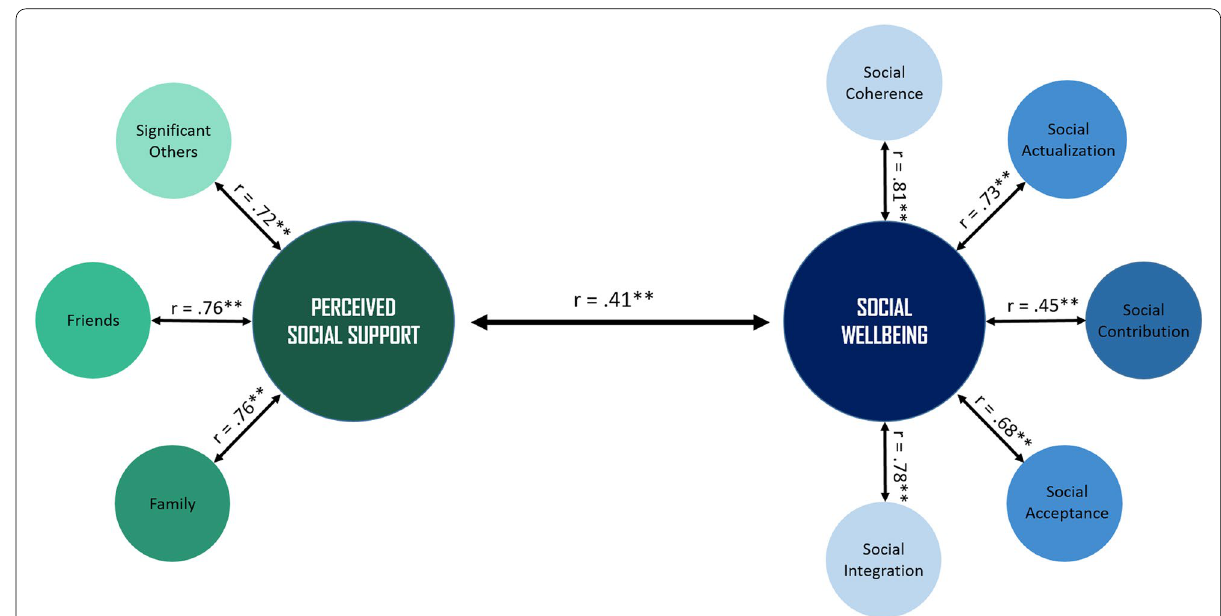
Fig. 1 Relationship of perceived social support and social